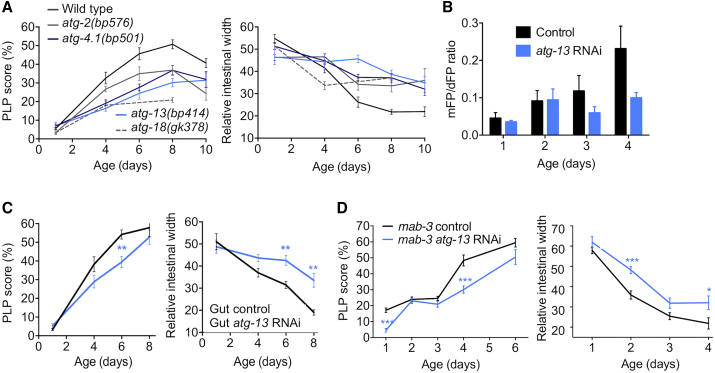
Evidence that Intestinal Autophagy Promotes Intestinal Atrophy and PLP Accumulation(A) Mutations in autophagy genes reduce age-associated PLP accumulation (left) and limit intestinal atrophy (right); N = 2 trials. All mutants were significantly different (p < 0.05) at 2 or more time points.(B) atg-13 RNAi suppresses the age increase in intestinal autophagy (p = 0.009, 2-way ANOVA). mFP/dFP, monomeric fluorescent protein, dual fluorescent protein.(C) Adult-limited atg-13 RNAi targeted to the gut reduces age-associated PLP accumulation (left) and intestinal atrophy (right); N = 2 trials.(D) Adult-limited atg-13 RNAi rescues PLP accumulation and gut atrophy in mab-3 males; N = 3 trials.∗p < 0.05, ∗∗p < 0.01, ∗∗∗p < 0.001. See also Figure S5.